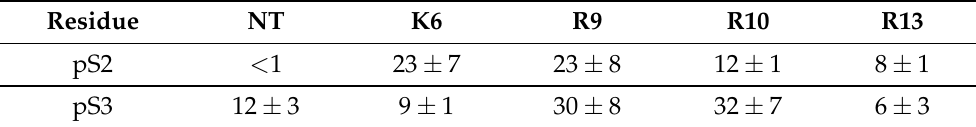
Table 7. Probability of salt bridge formation (%) between phosphorylated residues and positively charged residues in Stath, where NT is the N-terminus. The data are obtained from Ref. [31].